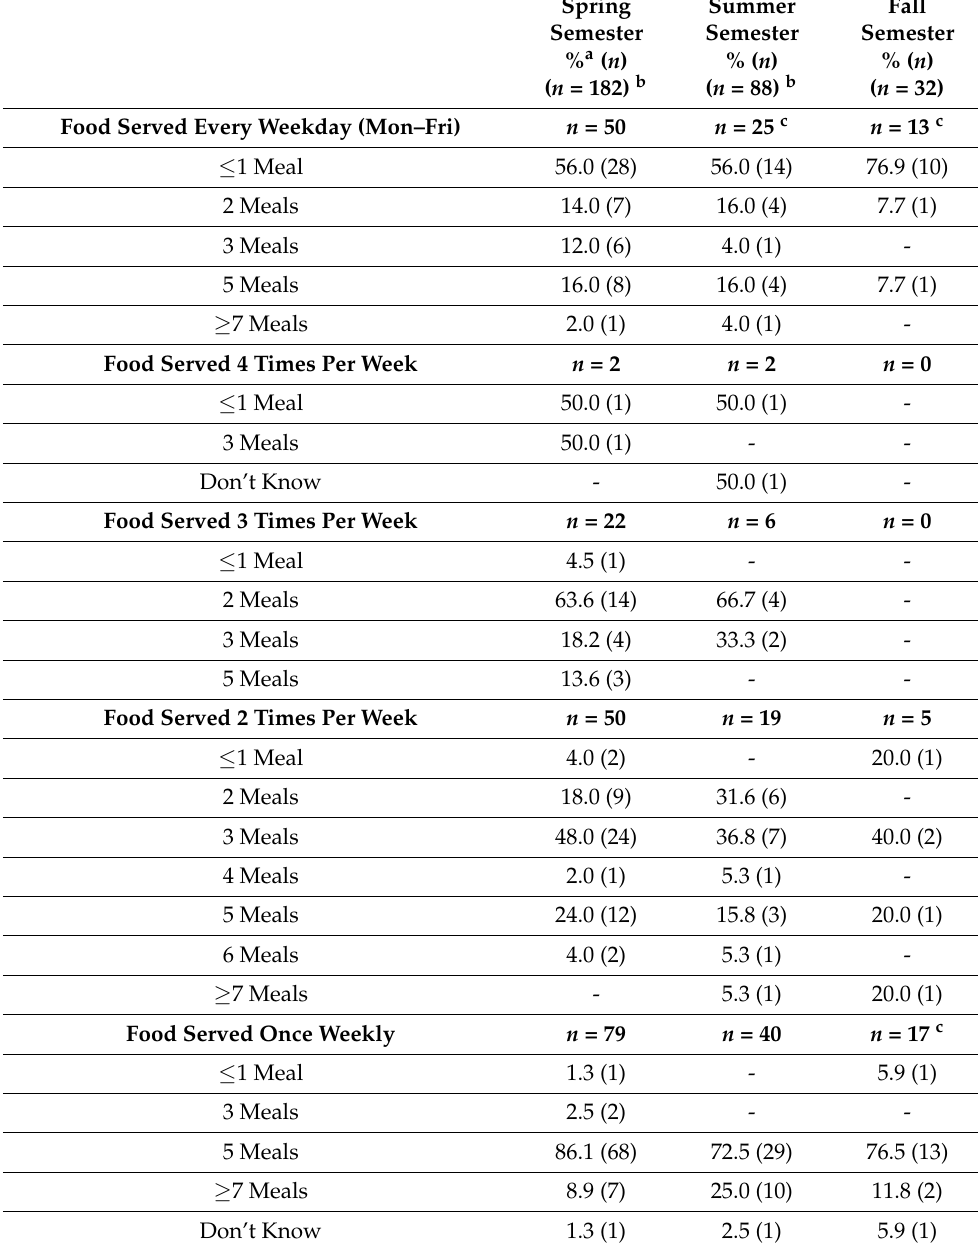
Table 3. Frequency and Quantity of Meals Provided a